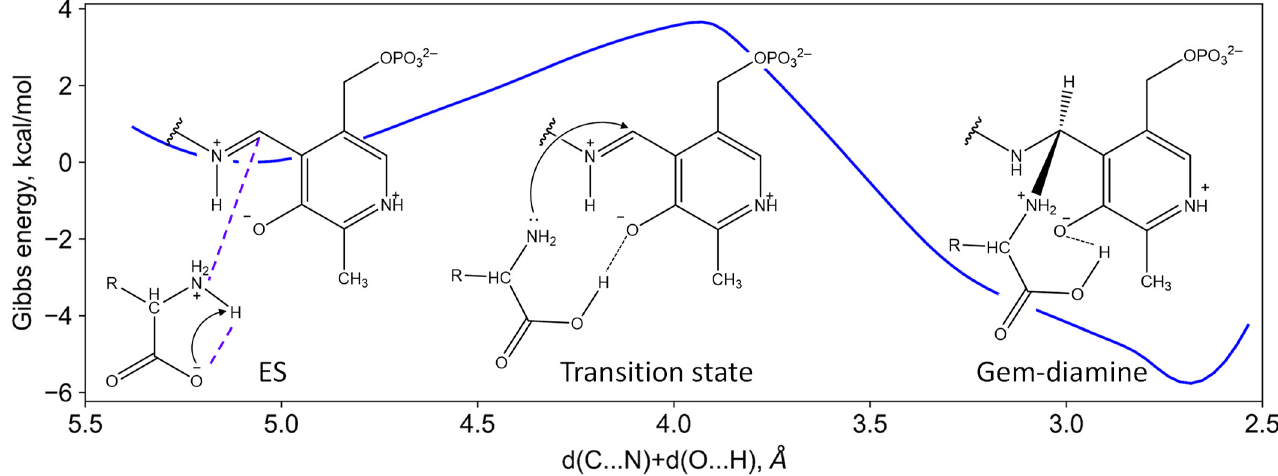
Figure 7. The first step of the reaction leading to the formation of the gem-diamine from the ES complex. Gibbs energy profile is shown in blue, dashed black lines are for hydrogen bonds and dashed violet lines are for the interatomic distances comprising reaction coordinate.